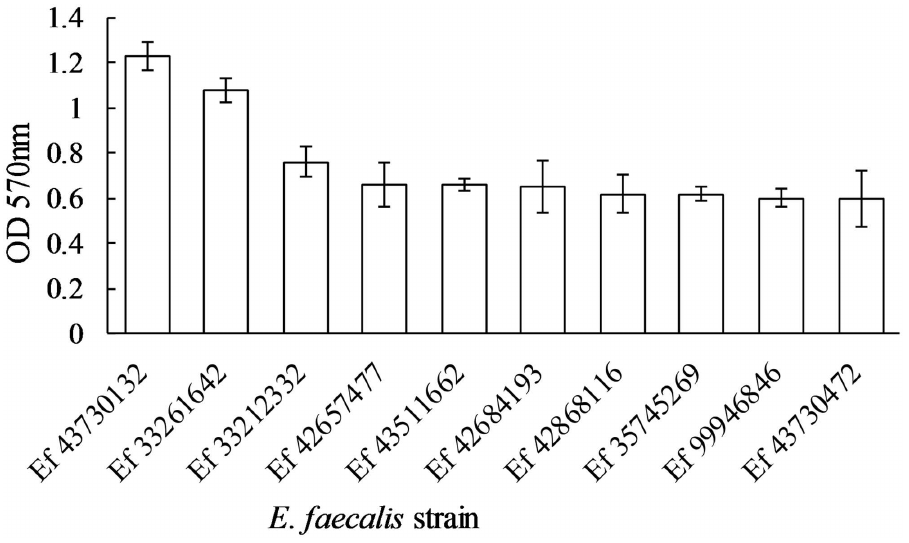
Fig 1. Mean optical density of each E. faecalis strain . Mean opticaldensity of the ten strains used in the study. Optical density (570nm) was proportional to biofilm growth as determined by the level of crystal violet stainingof the biofilm. The x-axis containsthe identification of each E . faecalis